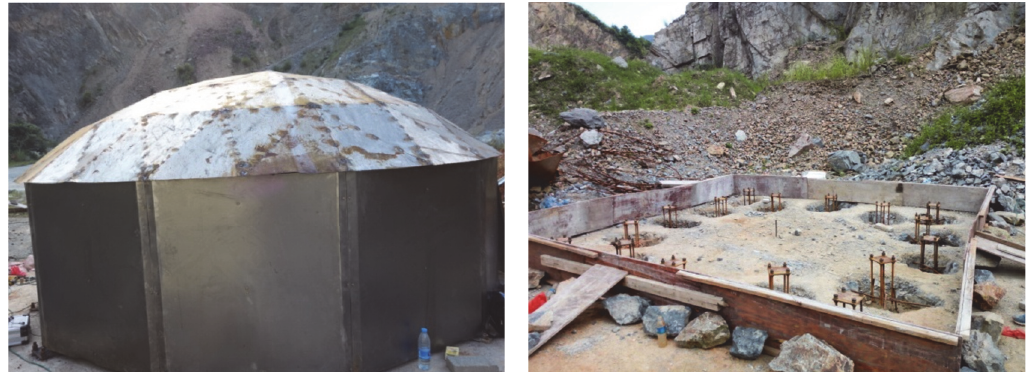
Figure 11: Diagram of experimental model and